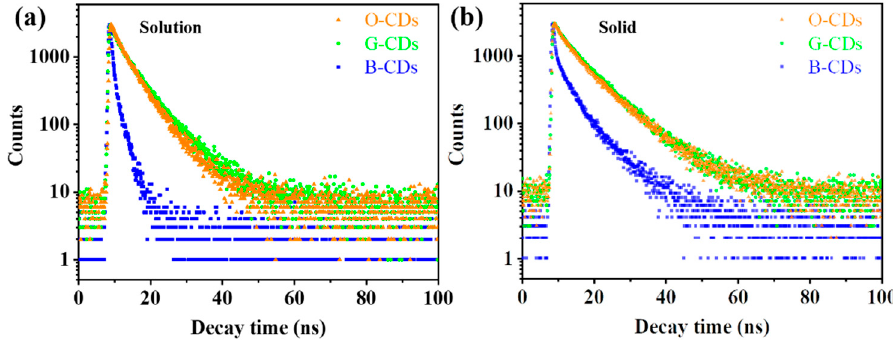
Figure 5. Fluorescence lifetime characterization of O-CDs, G-CDs and B-CDs in ethanol solution ( c = 0.1 mg/mL) ( a ) and in the solid state ( b ).